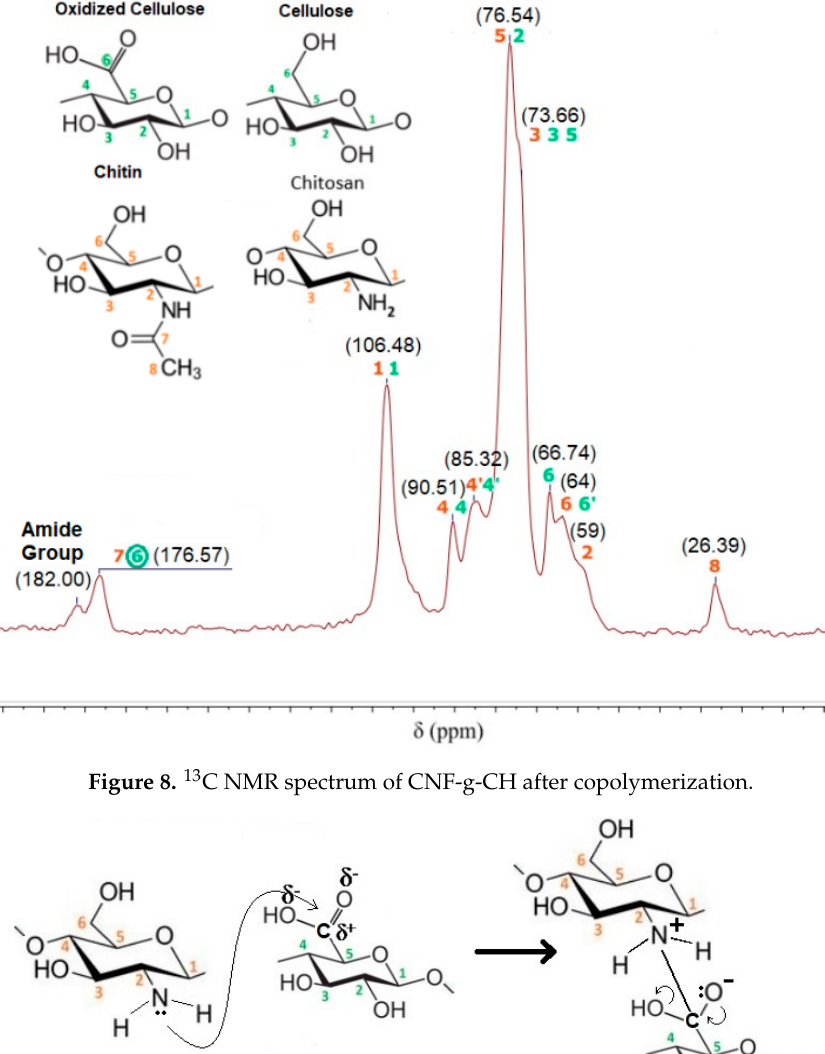
Figure 8. 13 C NMR spectrum of CNF-g-CH after copolymerization.